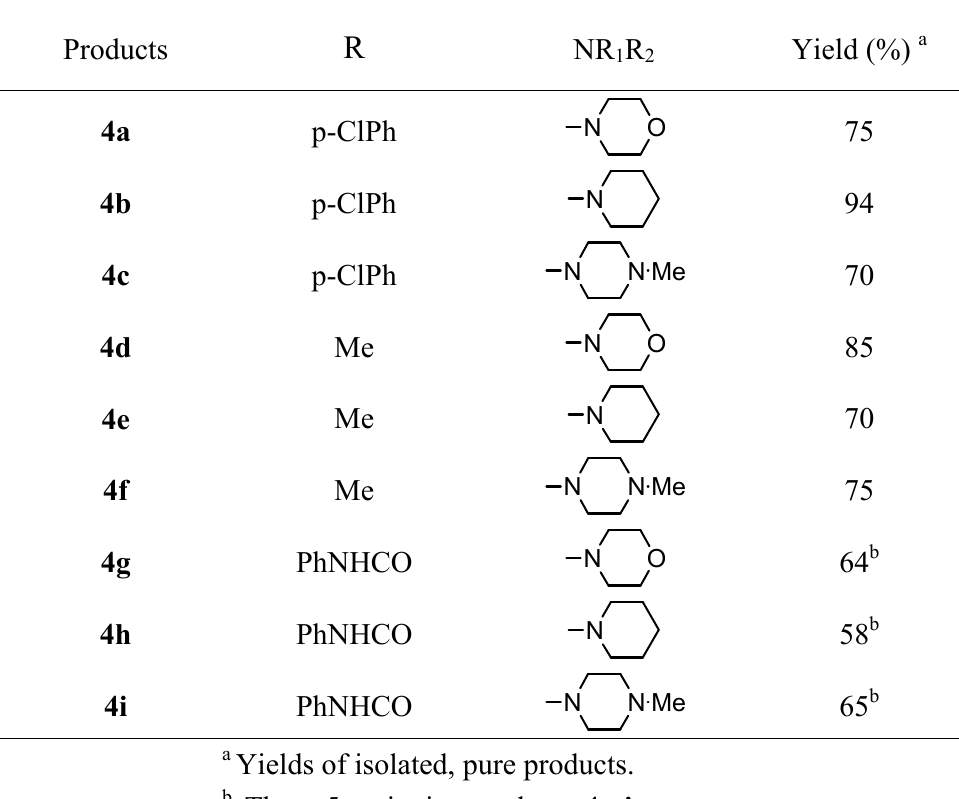
Table I. Preparation of